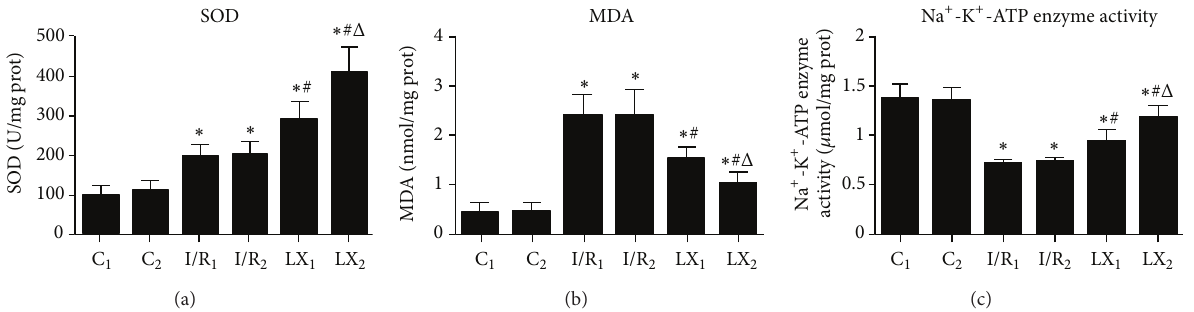
Figure 2: Comparison of cardiac MDA content and SOD and Na + -K + -ATPase activities at T 2 among all groups ( 𝑛 = 12 for each group). At time point T 2 , myocardial tissue was collected right after the I/R procedure was over and kept frozen in liquid nitrogen. MDA content and SOD and Na + -K + -ATPase activities were measured as described in the section of Materials and Methods. (a) SOD activity; (b) MDA content; (c) Na + -K + -ATPase activity. ∗ 𝑃 < 0.05 for comparisons of I/R 1 and LX 1 groups with C 1 group, 𝑃 < 0.05 for comparisons of I/R 2 and LX 2 with C 2 group; # 𝑃 < 0.05 for comparisons of LX 1 group with I/R 1 group, 𝑃 < 0.05 for comparisons of LX 2 group with I/R 2 group; Δ 𝑃 < 0.05 for comparisons of LX 2 group with LX 1